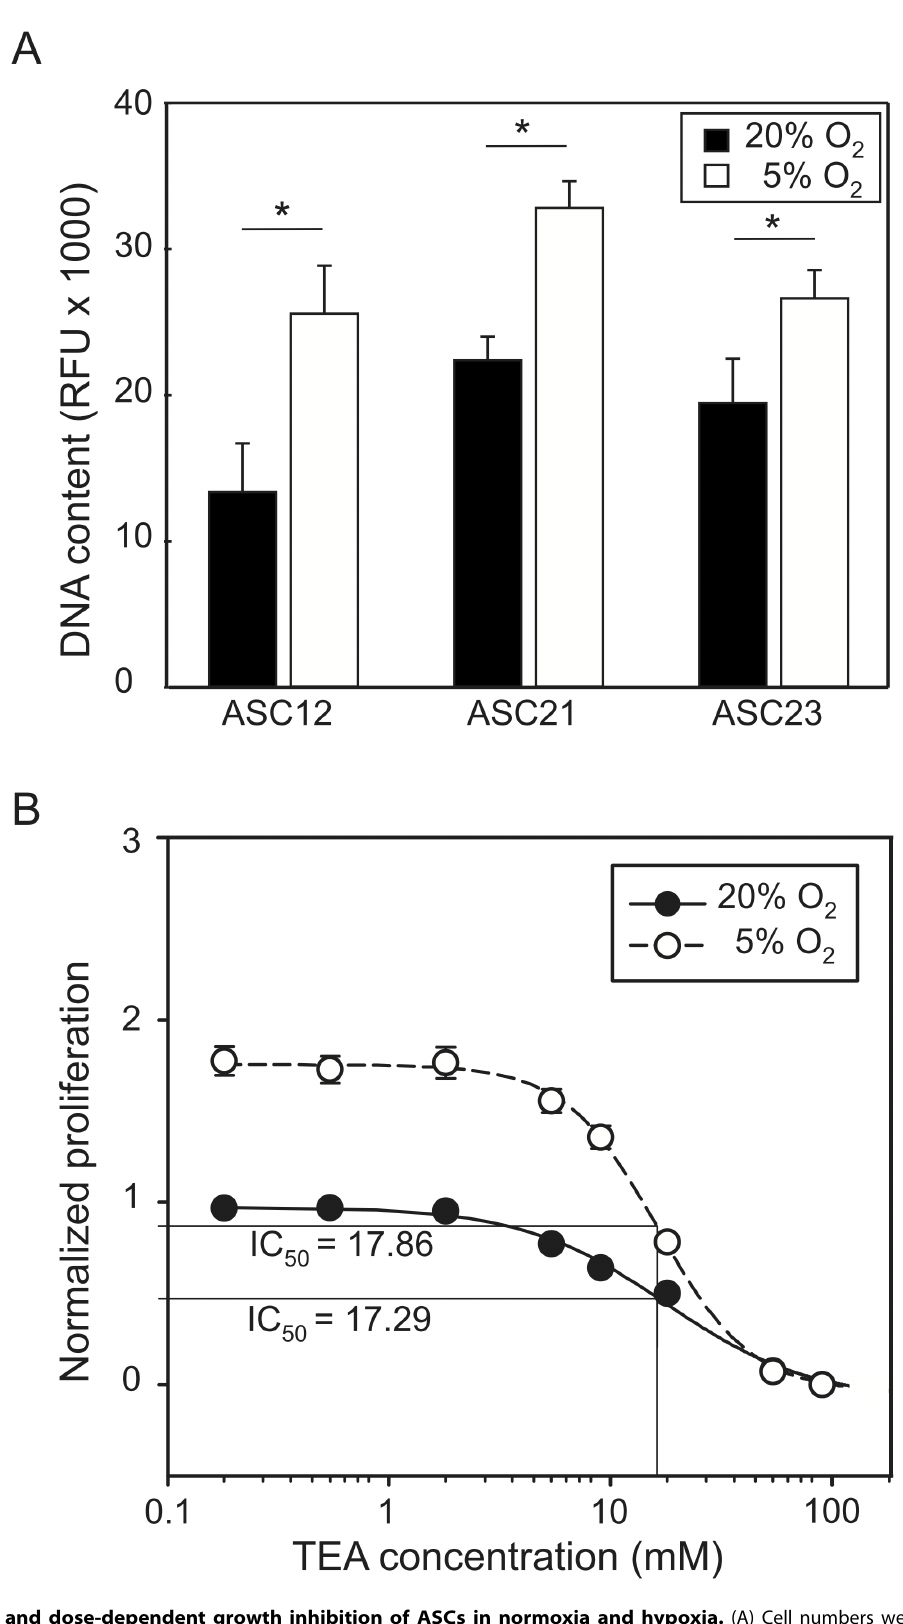
Figure 1. Growth and dose-dependent growth inhibition of ASCs in normoxia and hypoxia. (A) Cell numbers were greatly increased under hypoxic conditions after 4 days in culture for all three cell cultures (n=6). Asterisk denotes statistically significant difference (p , 0.01). (B) Dose- dependent growth inhibition of ASCs by TEA. The data were obtained from repeated experiments using all three cell cultures (n=6) and was normalized to the number of cells in normoxic cultures without TEA. The half maximal inhibitory concentration (IC 50 ) is indicated. doi:10.1371/journal.pone.0104912.g001 PLOS ONE | www.plosone.org